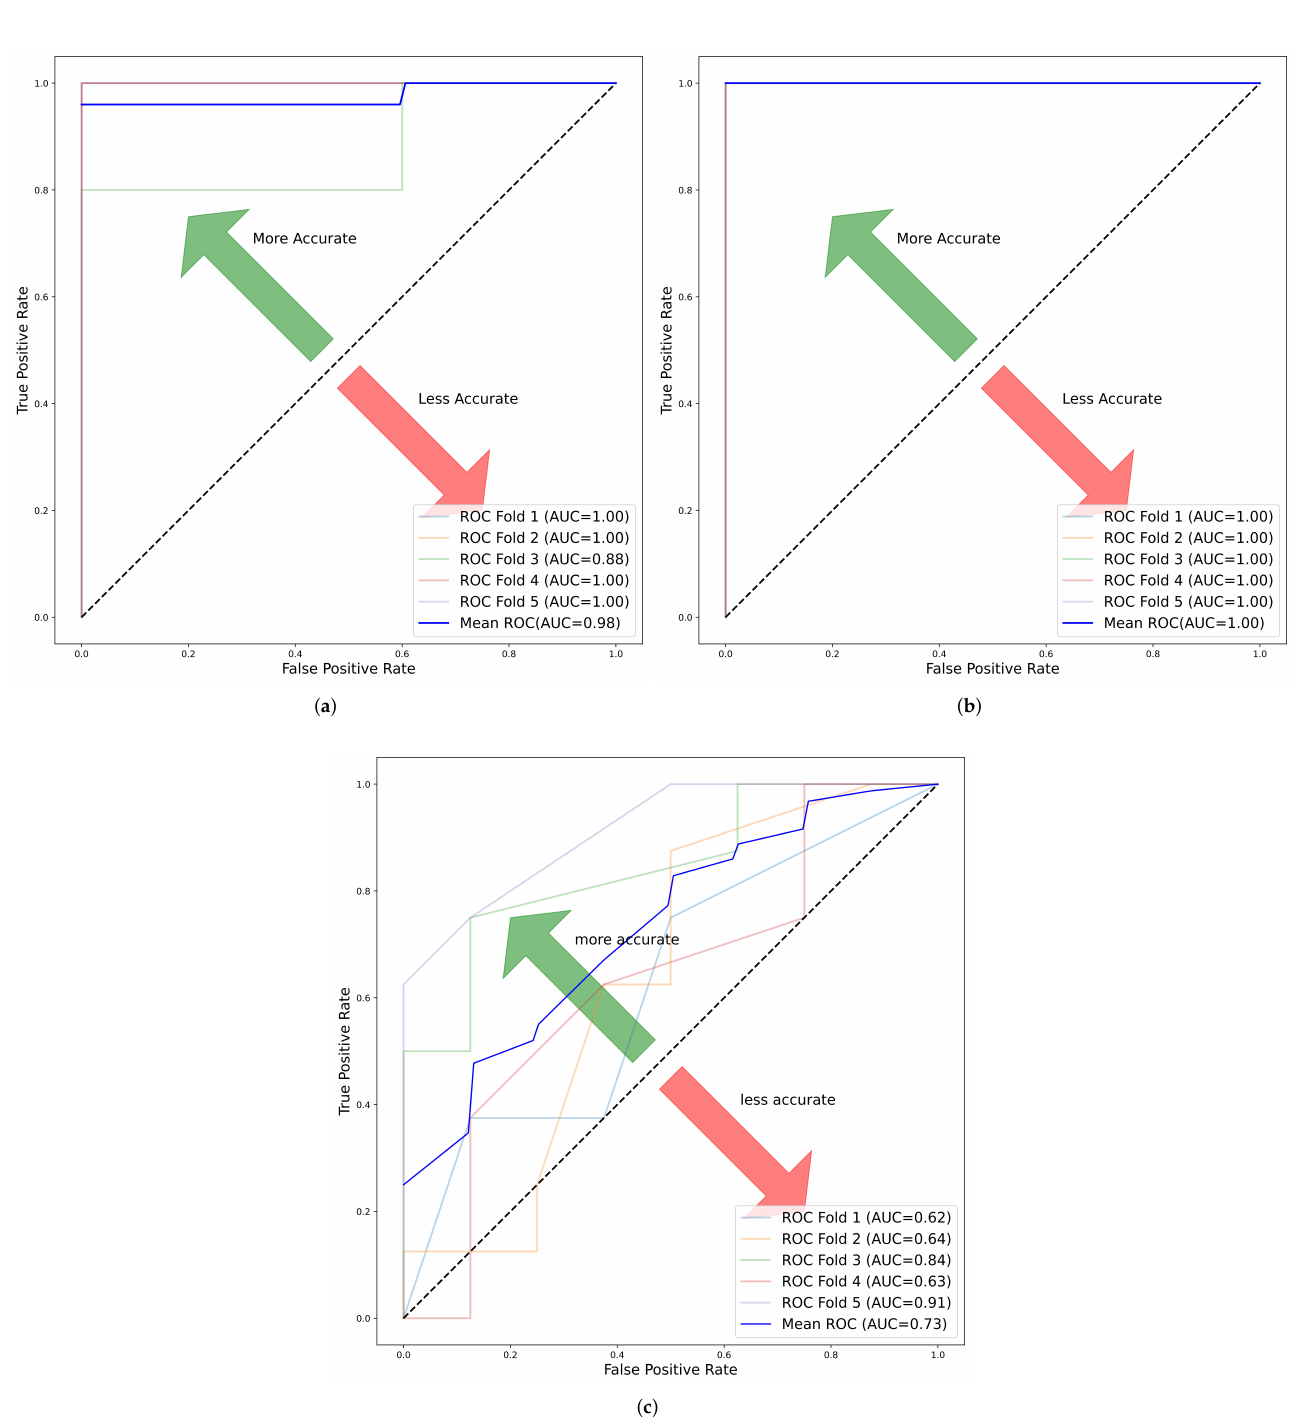
Figure A1. ( a ) ROC SVM Largest Tumor Slice Filtered Cohort 1. ( b ) ROC SVM Largest Tumor Slice Filtered Cohort 2. ( c ) ROC KNN Largest Tumor Slice Original Combined